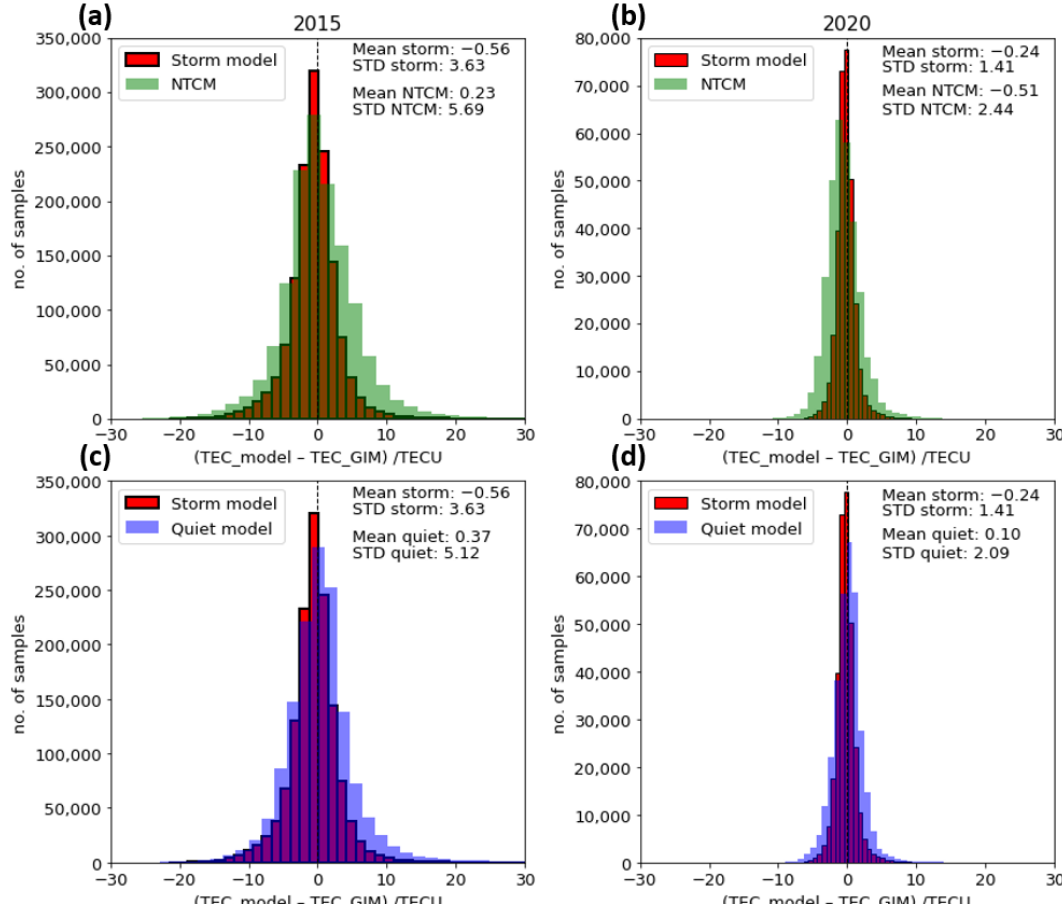
Figure 8. The performance of the storm model, quiet-time model and Neustrelitz TEC model (NTCM) in TECU. The left panels ( a , c ) correspond to the high-solar-activity (HSA) year in 2015 and the right panels ( b , d ) to the low-solar-activity (LSA) year in